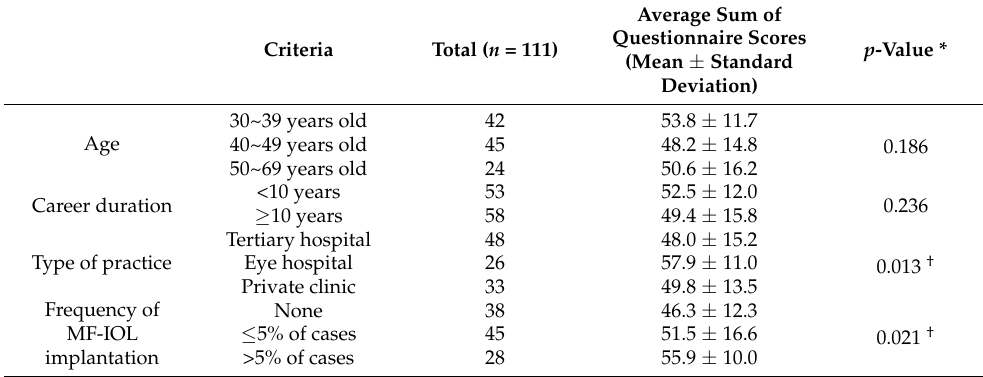
Figure 2. Box plots of the opinions of Korean retinal specialists on implanting diffractive MF-IOLs in eyes with 15 retinal diseases/statuses. Korean retinal specialists’ opinions on implanting MF-IOLs, reported on a 7-point Likert scale; the minimum, 1st quartile (25%, lower limit of box), median value (50%, middle line in box), 3rd quartile (75%, upper limit of box), and maximum are presented in a box plot for each retinal disease/status. The respondents used a 7-point Likert scale, where a rating of 1 means “completely disapprove”; 2, “strongly disapprove”; 3, “slightly disapprove”; 4, “neither approve nor disapprove”; 5, “slightly approve”; 6, “strongly approve”; and 7, “completely approve”. AMD, age-related macular degeneration; CSC, central serous chorioretinopathy; GA, geographic atrophy; NPDR, nonproliferative diabetic retinopathy; ME, macular edema; MF-IOL, multifocal intraocular lens; PDR, proliferative diabetic retinopathy; RD, retinal detachment; RVO, retinal vein occlusion. Table 3. Factors that may influence the opinions of retinal